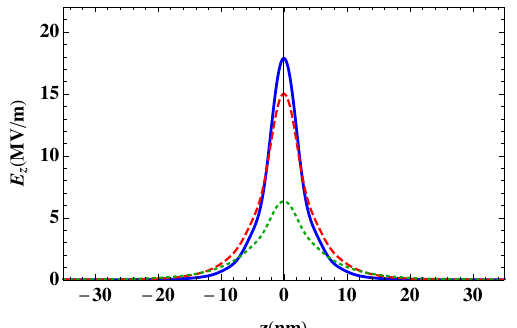
Figure 4. Confined plasmonic fields near the GNDs layer with thickness of t = 0.34 nm, Fermi energy of E F = 1 eV and mobility of 20,000 cm 2 /V s, excited by a 10 fs-sech pulse of λ 0 = 30 µ m, in the presence of metallic contact, i.e., an Ag NPs lattice of width W = 0.25 λ 0 at x / W = 0.45 with δ GNDs = (dotted). The two lattices are embedded in a dielectric of (cid:101) =